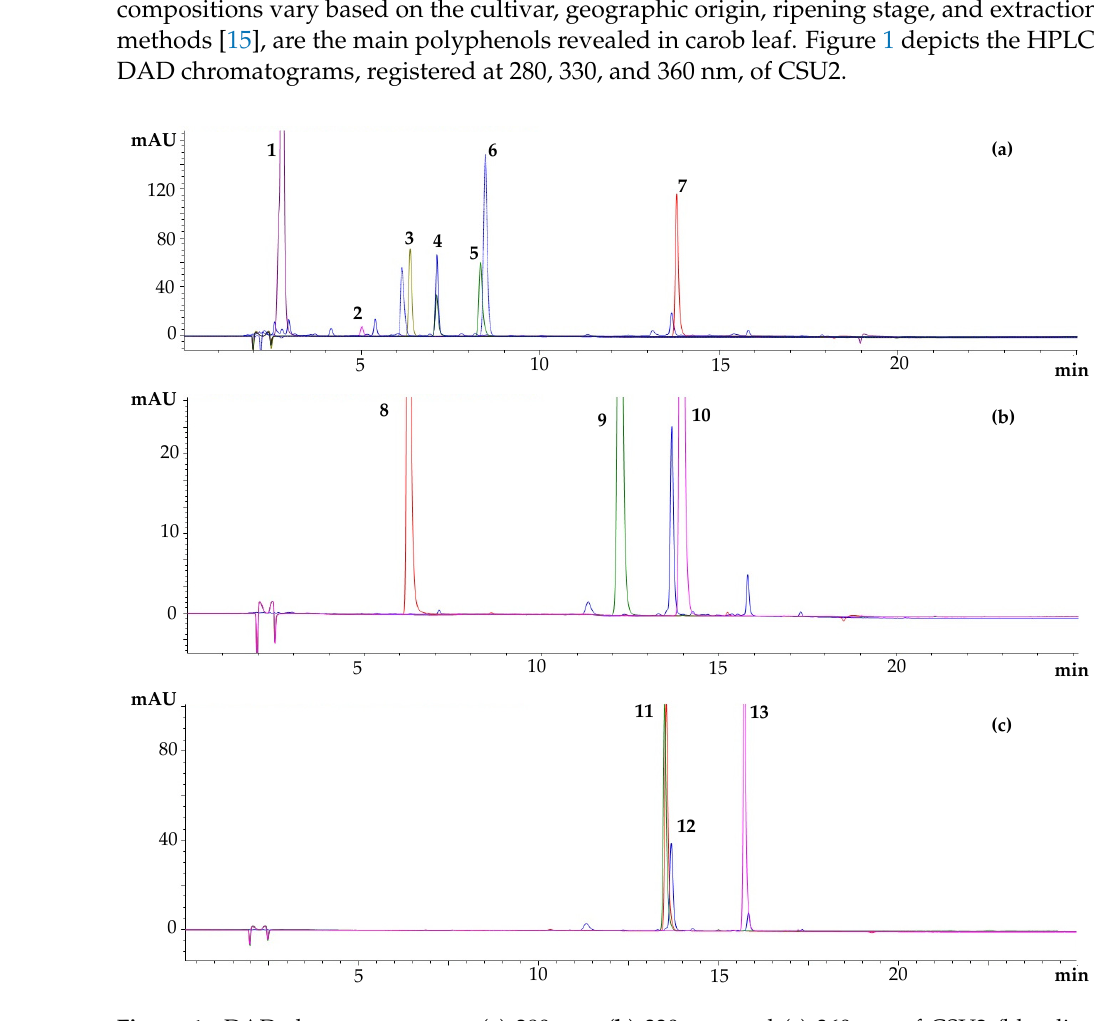
Figure 1. DAD chromatograms at ( a ) 280 nm, ( b ) 330 nm, and ( c ) 360 nm of CSU2 (blue line) compared to reference standards of (1) gallic acid, (2) epigallocatechin, (3) catechin, (4) 4-hydroxy- benzoic acid, (5) epigallocatechin gallate, (6) syringic acid, (7) epicatechin gallate, (8) chlorogenic acid, (9) 4-hydroxy-coumaric acid, (10) ferulic acid, (11) rutin, (12) myricitrin, and (13)